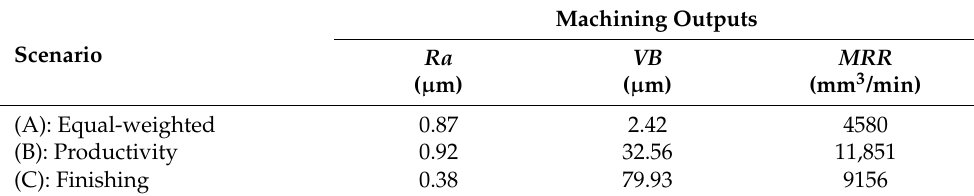
Table 6. A summary of the optimal solutions for the studied scenarios.